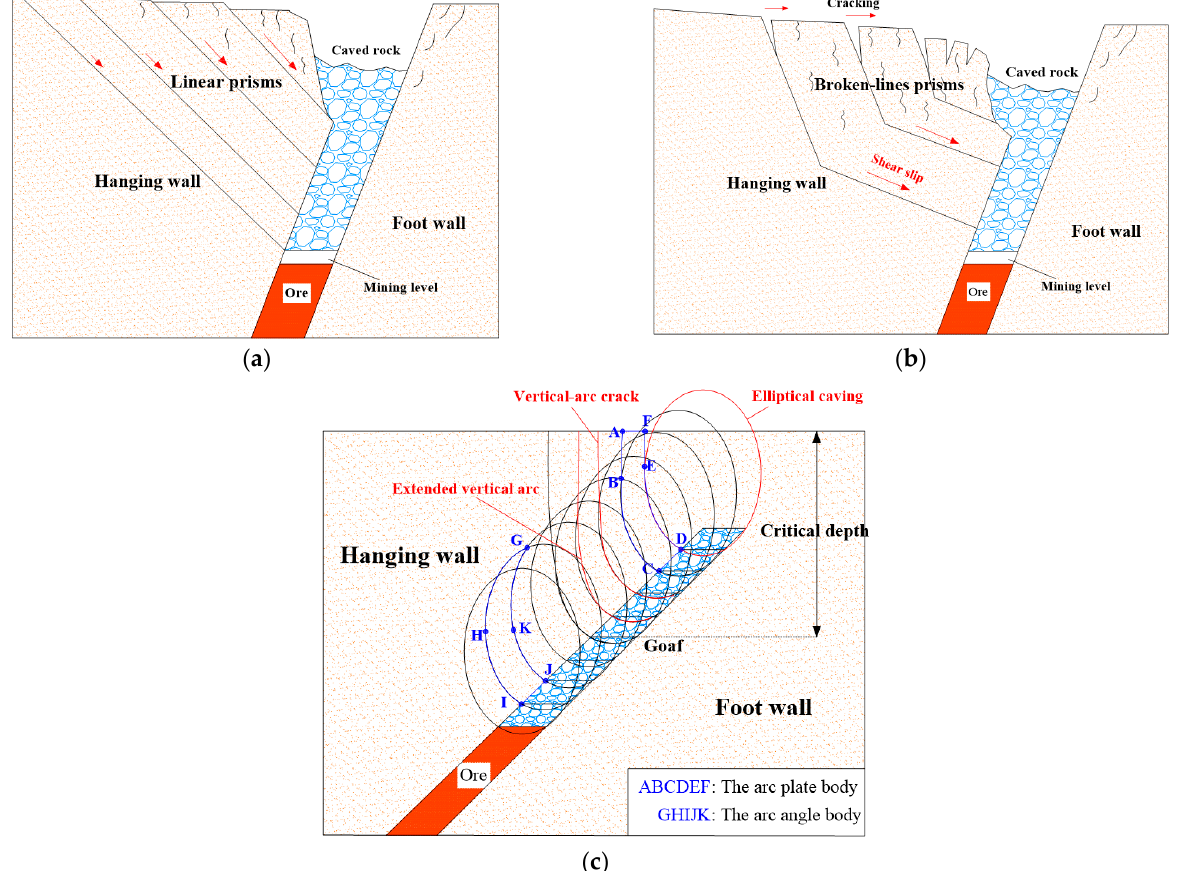
Figure 1. Several theoretical models of rock mass collapse. ( a ) Linear prism model; ( b ) broken-lines prism model; ( c ) arc plate model.